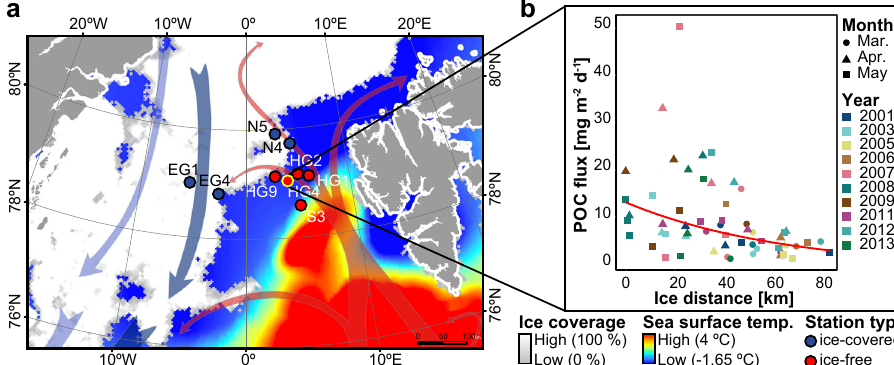
Fig. 1 Overview of sampling area in the Fram Strait. a Monthly average of sea ice cover and sea surface temperature during July 2016. The arrows represent general directions of the West Spitzbergen Current (in red) and the East Greenland Current (in blue). The yellow edge of the HG4 station indicates the position of a long-term sediment trap deployment. b Particulate Organic Carbon (POC) fl ux collected at 200 m by a long-term moored sediment trap between 2001 and 2013 during the early spring (March-May), plotted as a function of the distance to the ice-edge. The regression shows that there was a signi fi cantly negative relationship between the distance to the ice-edge and the magnitude of POC fl ux ( y = 13.6 × e − 0.015 × x ), R 2 = 0.2, p <